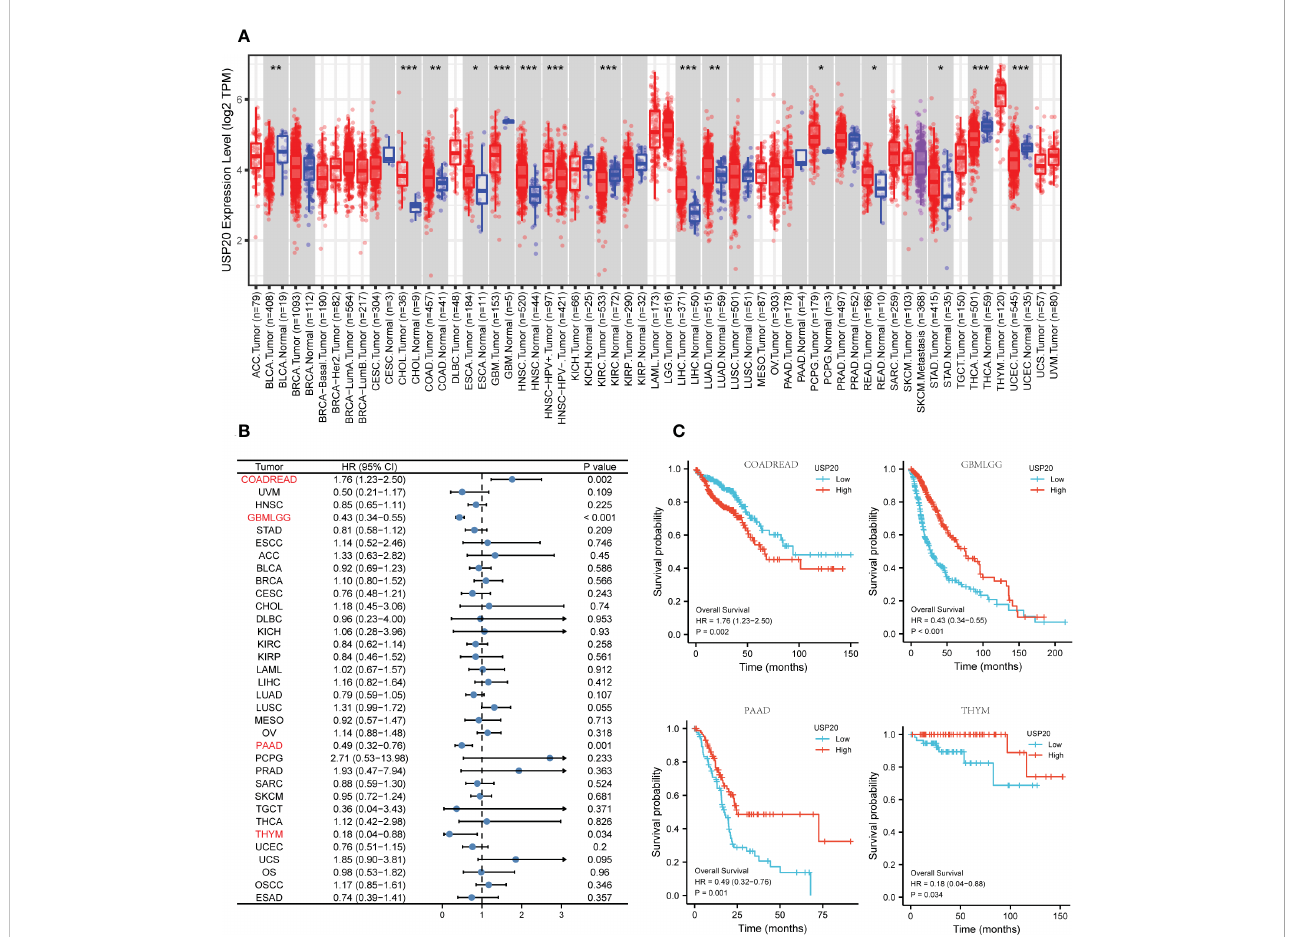
FIGURE 1 Pan-cancer analysis of USP20; (A) USP20 expression of different tumor types and normal tissue in TCGA were analyzed by the TIMER online database; (B, C) Univariate survival analysis was used to analyze the relationship between USP20 expression and survival time in Pan cancer; (B) forest plot showing the relationship between USP20 expression and OS; (C) KM curves of high and low USP20 expression in Pan cancer signi fi cantly associated with OS survival; (*P < 0.05; **P < 0.01; ***P < 0.001; ****P < 0.0001; NS, not signi fi